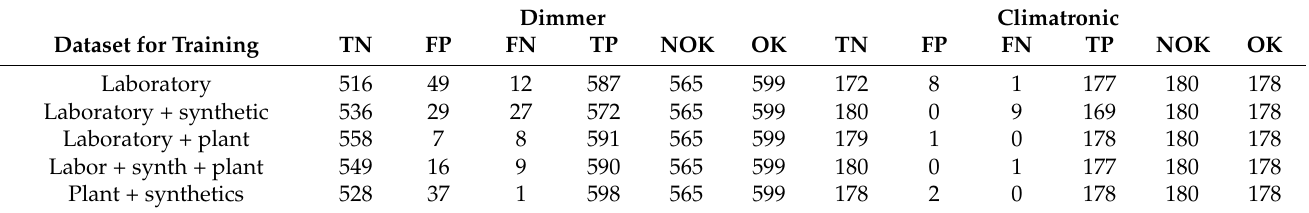
Table 4. Results obtained for both devices (Dimmer and Climatronic) for each of the training sets. Dimmer Climatronic Dataset for